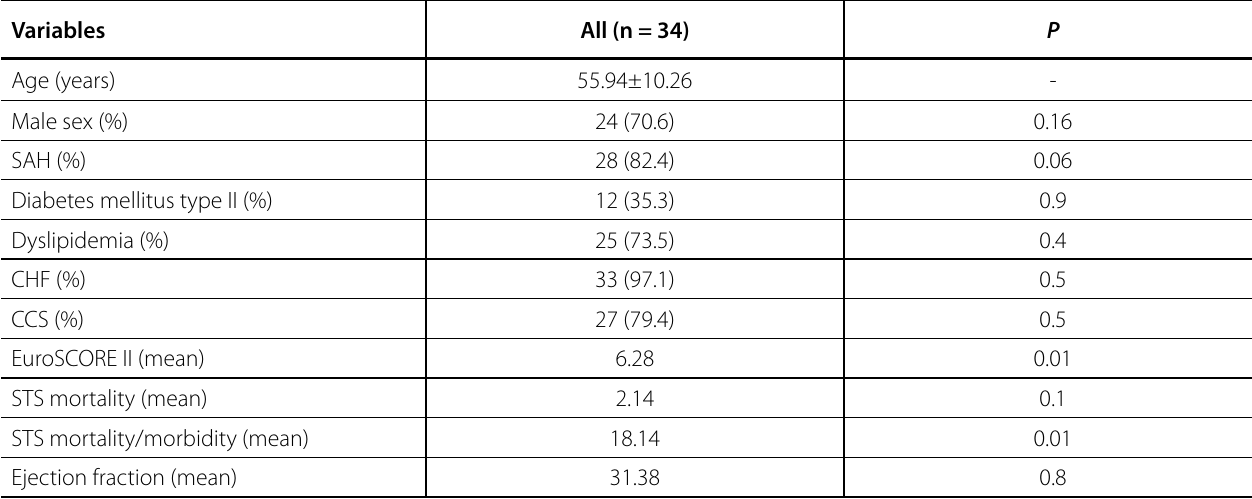
Table 1 . Patients' preoperative characteristics.